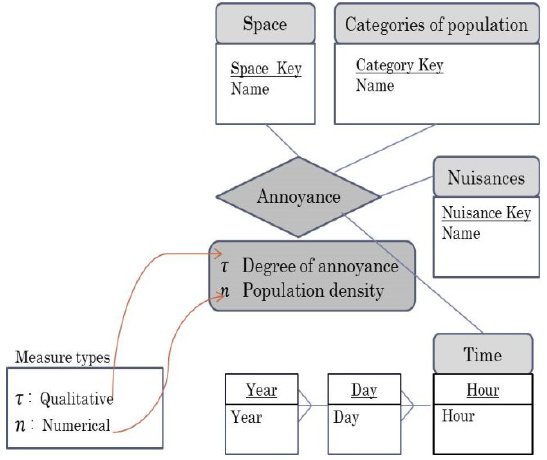
Figure 2. Multidimensional data model of